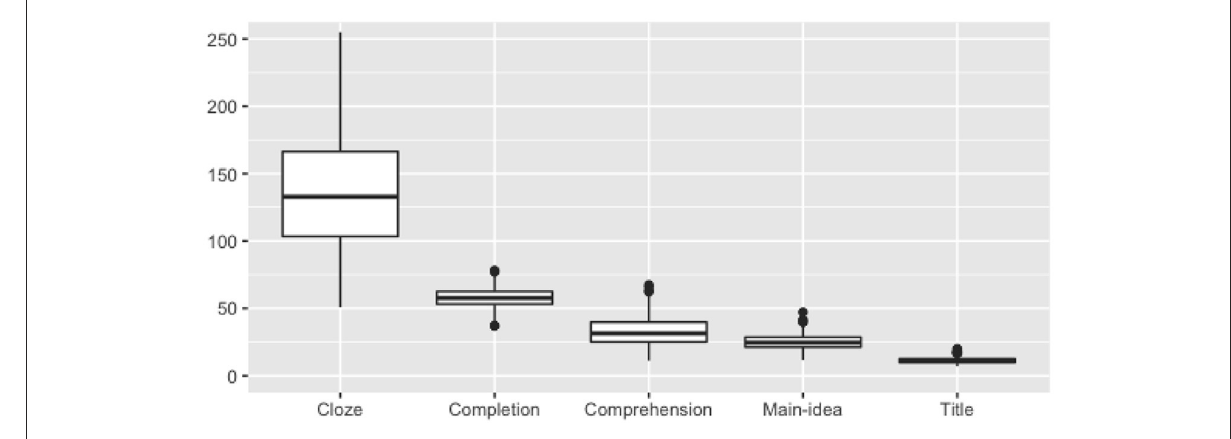
FIGURE1 Median response time distributions (in seconds).